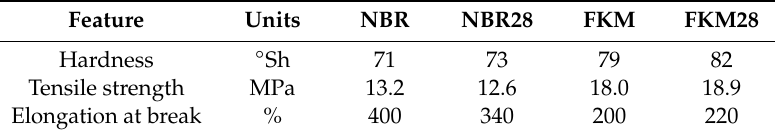
Table 2. The basic properties of ring materials.